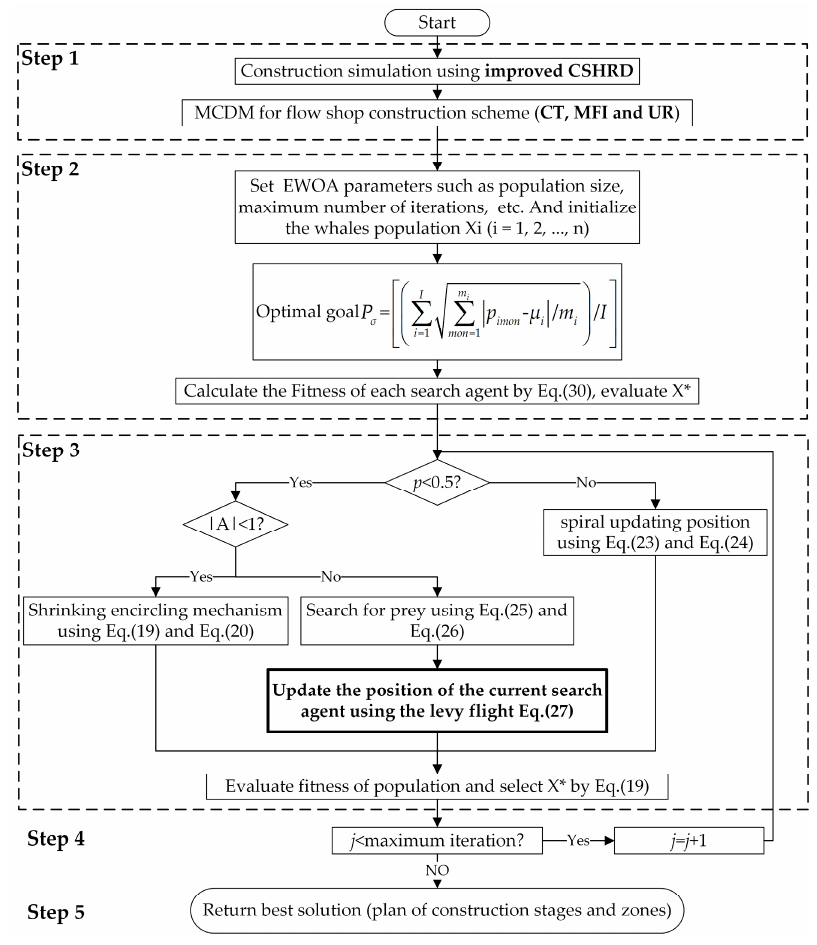
Figure 7. Flow chart of construction stage and zone optimization with enhanced whale optimization algorithm (EWOA).